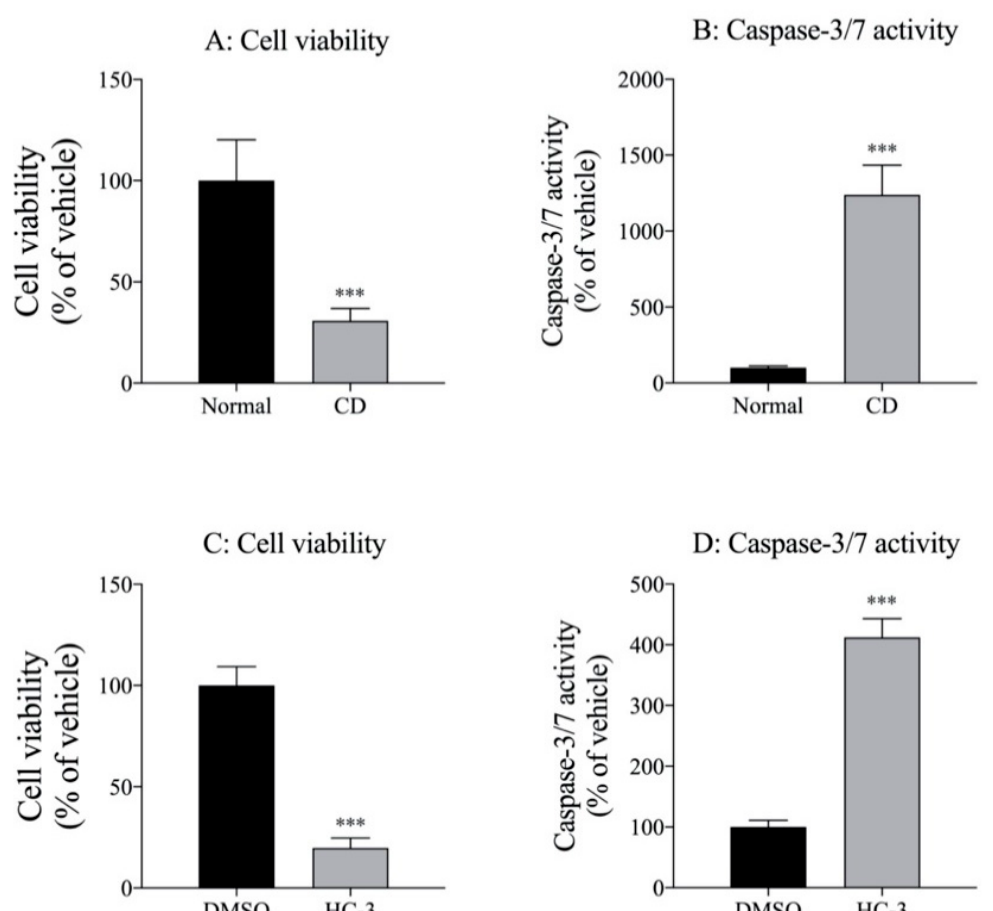
Figure 4. Effect of choline deficiency (CD) on ( A ) cell viability and ( B ) caspase-3/7 activity in MIA PaCa-2 cells. Cells cultured in 30 mM choline chloride (Normal) or without choline chloride (CD) medium for 2 days ( n = 4). Results calculated as 100% of findings under normal conditions; *** p < 0.001 for unpaired t -test compared to normal conditions. Effect of HC-3 on ( C ) cell viability and ( D ) caspase-3/7 activity in MIA PaCa-2 cells ( n = 4). Cells incubated in 1% DMSO (vehicle control) and 1 mM HC-3 for 2 days; then, cell numbers and caspase-3/7 activity were measured. Results calculated as 100% of findings in vehicle control (DMSO); *** p < 0.001 for unpaired t -test compared to vehicle control (DMSO).